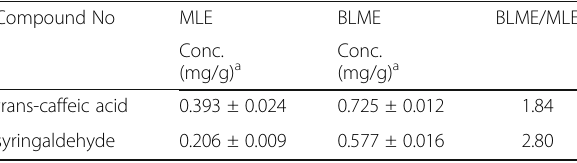
Table 1 Quantitative analysis of two marker compounds in mulberry leaf extract (MLE) and bioconverted mulberry leaf extract (BMLE). ( n =